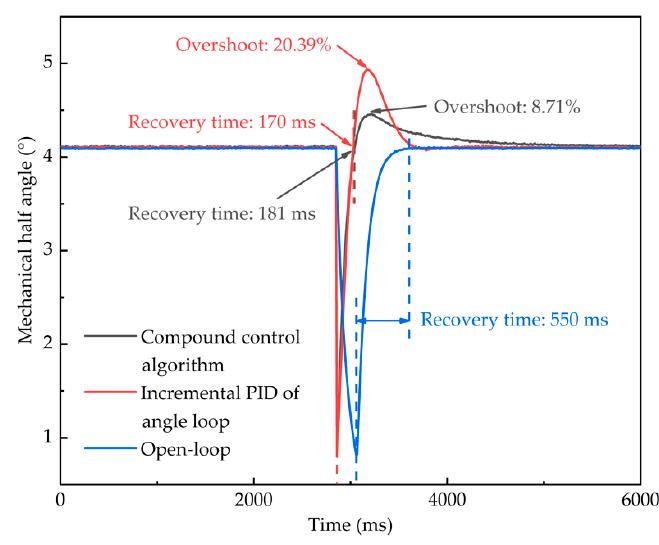
Figure 14. Anti-interference test of scanning micrograting under different conditions.